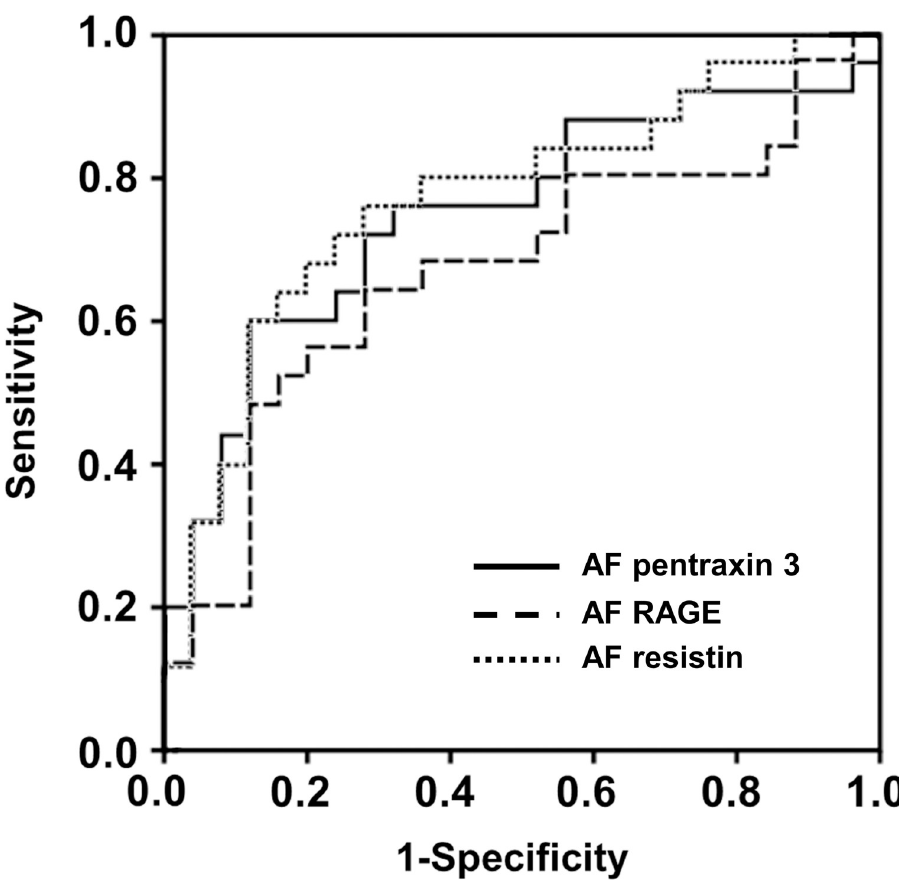
Fig 1. Receiver-operating characteristic curves for predicting spontaneous preterm delivery at < 34 weeks of gestations by the pentraxin 3, RAGE, and resistin levels in AF. PTX3: AUC, 0.749 ± 0.071; P = 0.003. RAGE: AUC, 0.669 ± 0.079; P = 0.041. resistin: AUC, 0.770 ± 0.068; P = 0.001. AF, amniotic fluid; AUC, area under the curve ± standard error; RAGE, receptor for advanced glycation endproducts.